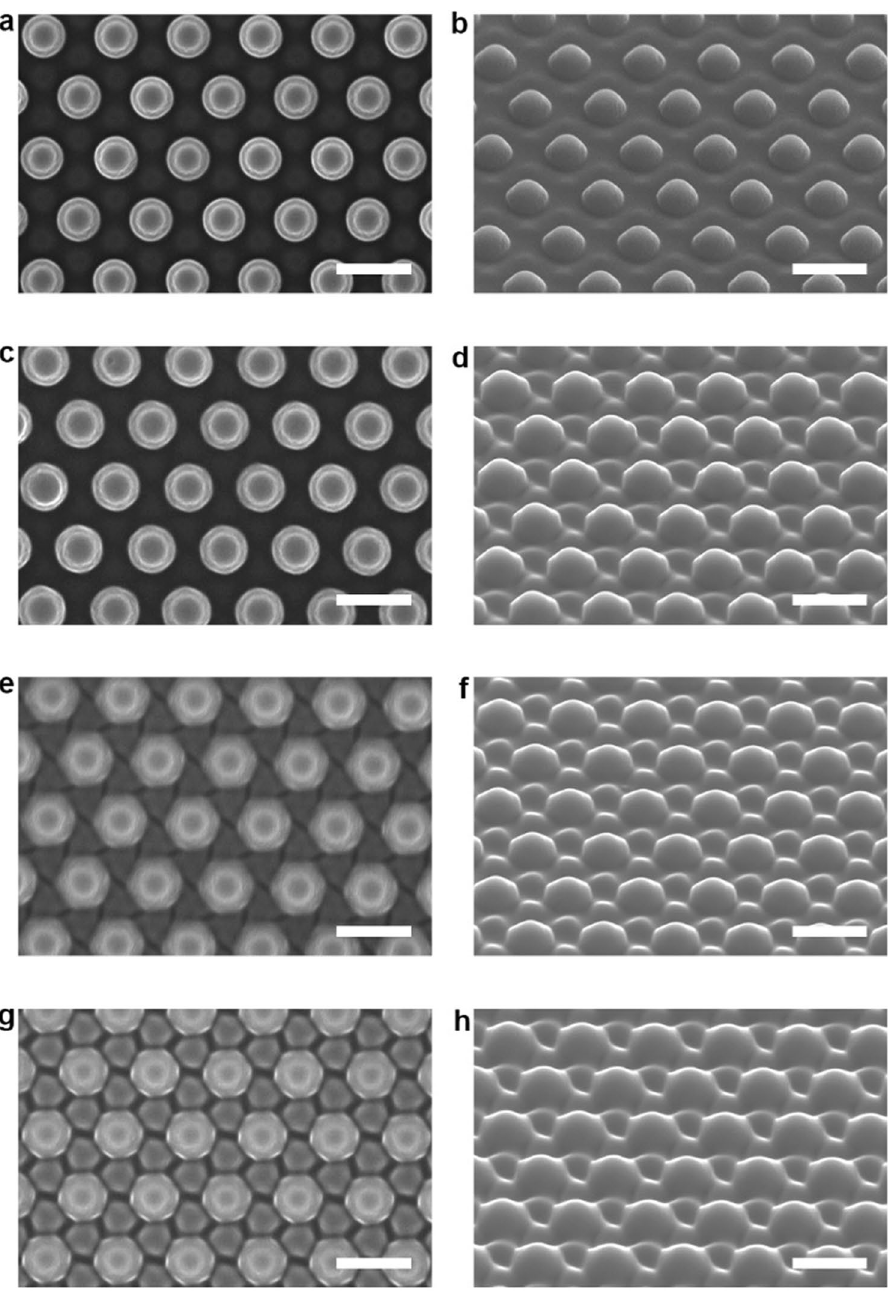
Figure 4. Typical SEM images of the IA-Chol submicron pillar arrays after irradiation with the right-hand circularly polarized light for different time periods. ( a ) Top-view SEM image of the array after being irradiated for 90 s. ( b ) Side-view SEM image corresponding to panel ( a ). ( c ) Top-view SEM image of the array after being irradiated for 4 min. ( d ) Side-view SEM image corresponding to panel ( c ). ( e ) Top-view SEM image of the array after being irradiated for 6 min. ( f ) Side-view SEM image corresponding to panel ( e ). ( g ) Top-view SEM image of the array after being irradiated for 8 min. ( h ) Side-view SEM image corresponding to panel ( g ). The light intensity was 300 mW cm −2 . The scale bars of all the SEM images correspond to 1